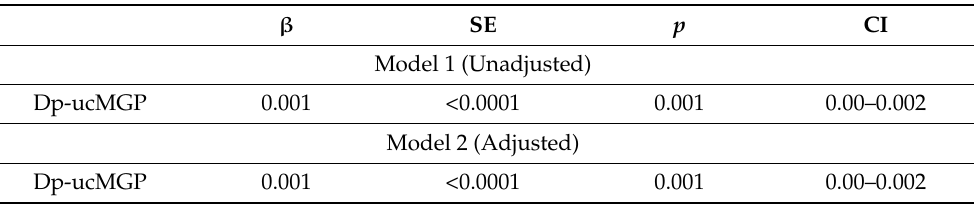
Table 4. Multiple regression analysis (stepwise forward) in 158 CKD patients with RDW as the dependent variable. β SE p CI Model 1 (Unadjusted) Dp-ucMGP 0.001 <0.0001 0.001 0.001 <0.0001 0.001